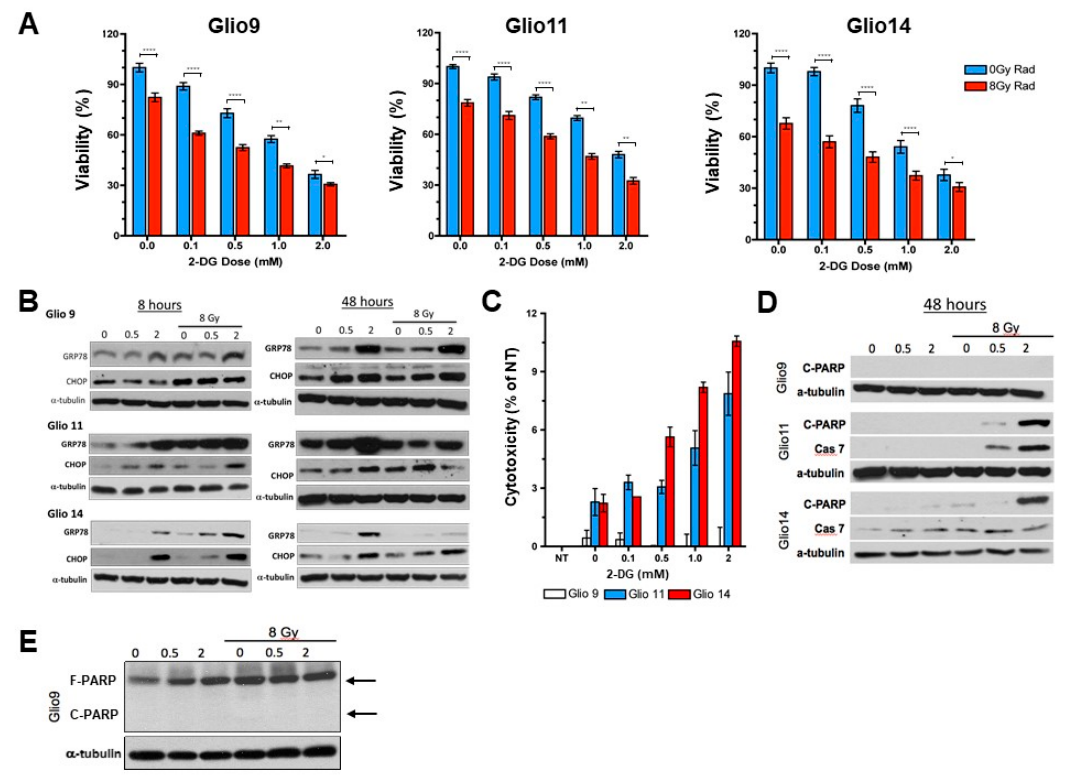
Figure 6. Radiotherapy and 2-DG cotreatment potentiates UPR and leads to dose-dependent loss of cell viability and apoptosis. ( A ) Proliferation assay of Glio9, Glio11, and Glio14 treated with increasing doses of 2-DG with or without 8 Gy radiation for 72 h. Viability is reported as mean ± SEM. Data represent average values of at least three independent experiments. * p < 0.05, ** p < 0.01, *** p < 0.001. Mann-Whitney Test. ( B ) Western blot analysis for ER stress markers GRP78 and CCAAT-enhancer-binding-protein homologous protein (CHOP) after treatment using increasing doses of 2-DG with or without 8 Gy radiation. Cells were analyzed at early (8 h) and late (48 h) time points. ( C ) Lactate dehydrogenase assay to determine cytotoxicity of Glio9 (white), Glio11 (blue), and Glio14 (red) treated with 2-DG. Cytotoxicity is reported as mean ± SEM. Data represent average values of at least three independent experiments. ( D ) Western blot analysis of apoptosis markers, cleaved-PARP and caspase-7, after 48 h treatment of GSCs using 2-DG with or without 8 Gy radiation. ( E ) Western blot of full-PARP and cleaved-PARP in Glio9 to confirm presence of full PARP and lack of PARP cleavage despite combination therapy.